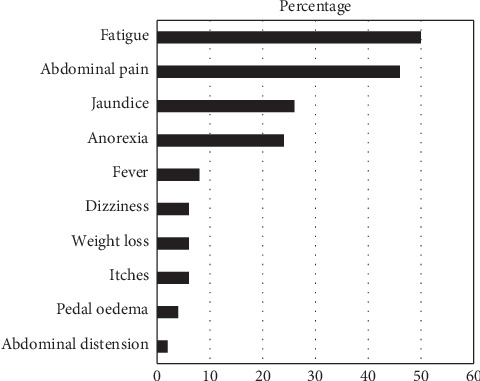
Symptoms of liver disease as stated by participants on day 0.